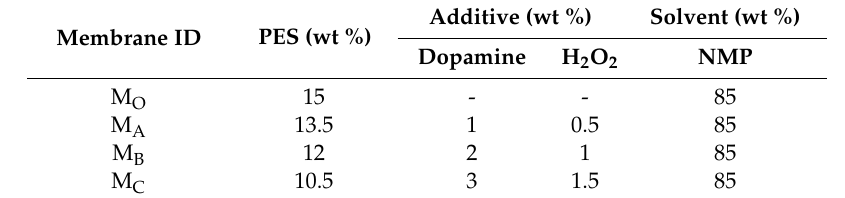
Table 1. Compositions of dope solution for membrane preparation.